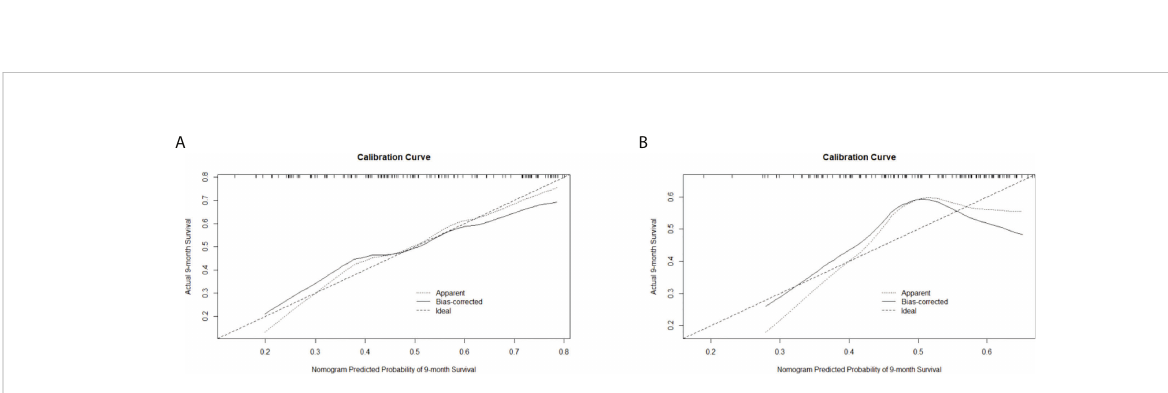
FIGURE 7 Calibration curves of (A) the radiomics-based nomogram and (B) clinical nomogram for the prediction of 9-month